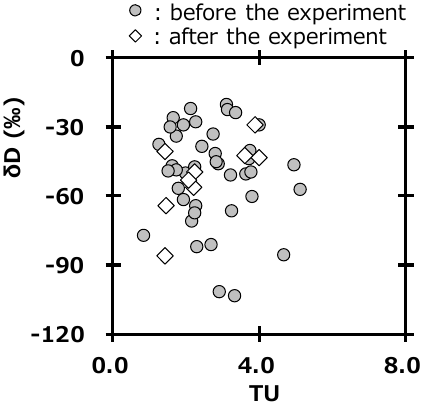
Figure 7. Relationship between tritium concentration (TU) and δ D in precipitation at Toki.